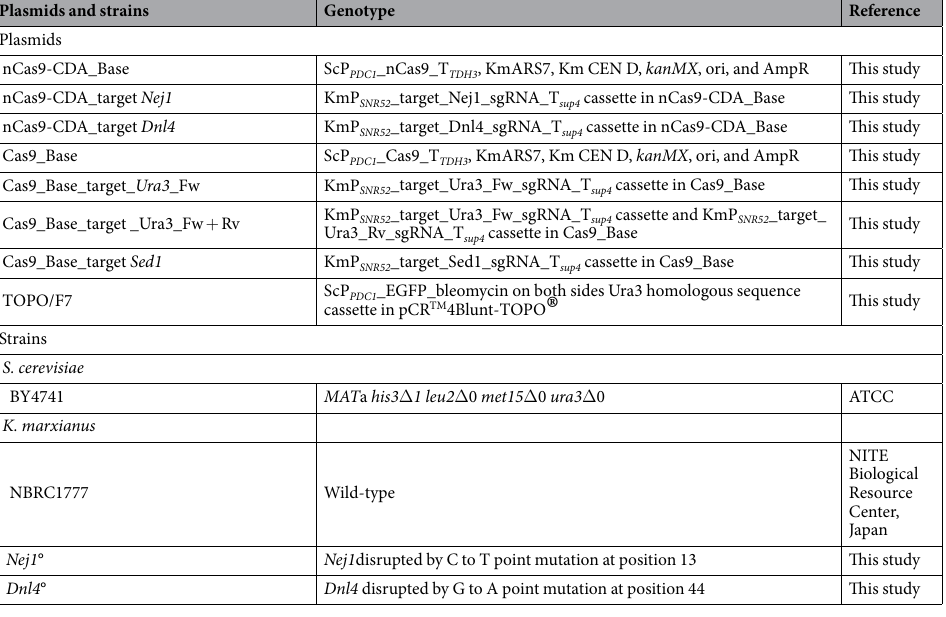
Table 1. Plasmids and strains used in this